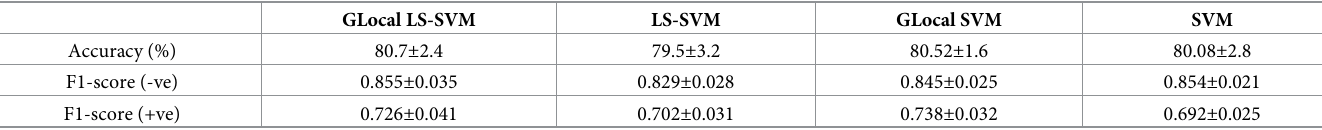
Table 7. Comparing the average error performance of the GLocal-LS-SVM and LS-SVM applied to the Pima Indians Diabetes dataset.